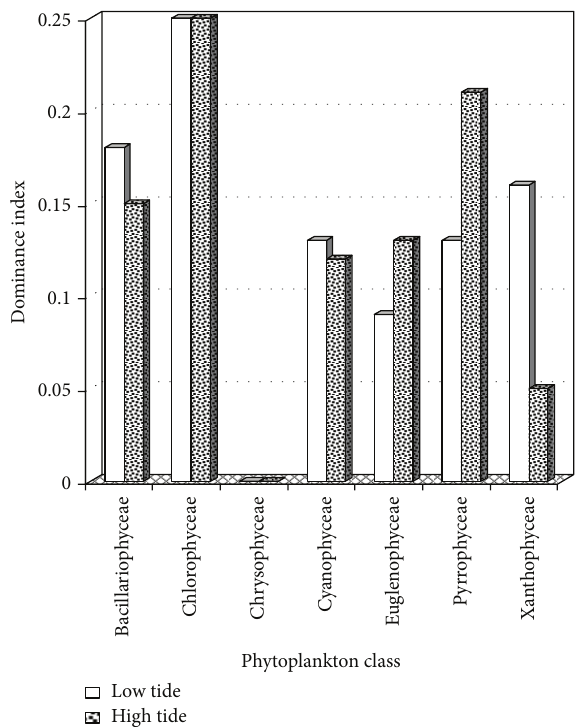
Figure 7: Variation of phytoplankton dominance index. Variations of phytoplankton parameters in relation to tide in Okpoka